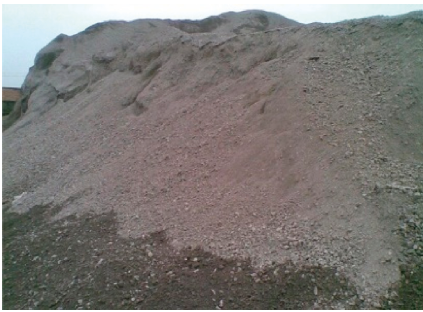
Figure 1: Tested steel